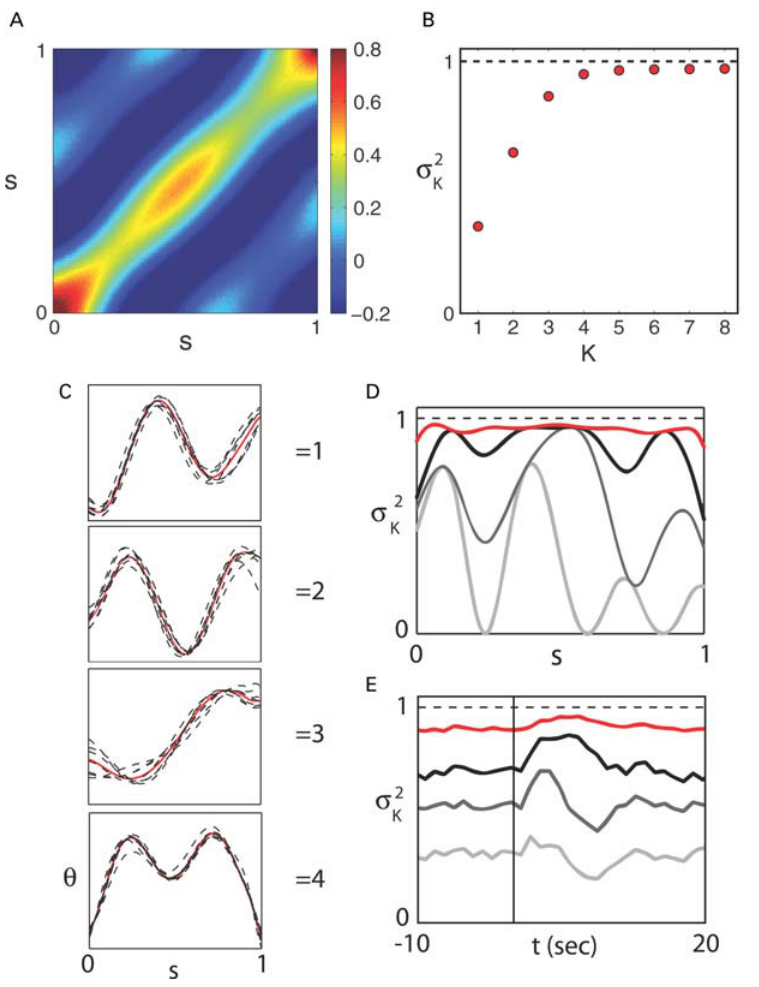
Figure 2. Covariance of shape fluctuations and eigenworms. (A) The covariance matrix of fluctuations in angle C ( s , s 9 ). The inhomogeneity along the diagonal shows that the normal modes of the motion are not sinusoidal but the smooth structure of C ( s , s 9 ) means that a small number of modes are significant. (B) We find the eigenvalues of C ( s , s 9 ) and compute s 2 K , the fraction of the total variance (integrated along the body of the worm) captured by keeping K modes (see Materials and Methods). (C) Associated with each dominant mode is an eigenvector and we refer to these as eigenworms u m (s). The population-mean eigenworms (red) are highly reproducible across individual worms (black). (D) The fraction of variance, s˜ 2 K , at each point along the body curve captured by keeping K modes ( K =1 to 4, from bottom to top curve). The overall error in reconstruction of the worm body curve decreases as the number of modes increases, but does so inhomogeneously. (E) In response to strong thermal stimuli, reconstructions using the eigenworms of spontaneous crawling continue to account for most of the shape variance. Worm images are recorded at times synchronized to a heat pulse and we display s 2 K aligned with this pulse (red line). ( K =1 to 4, from bottom to top curve).